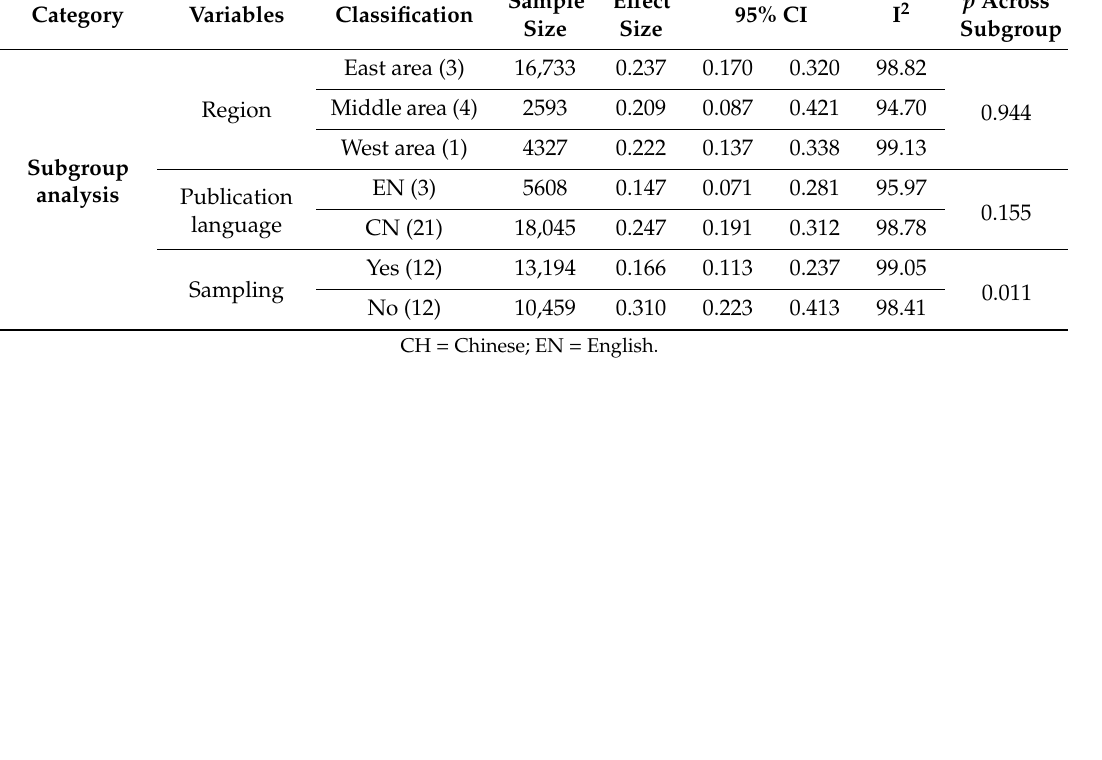
Figure 2. Forest plot of the prevalence of oral mucosal diseases in older adults. Table 2. Subgroup analyses.